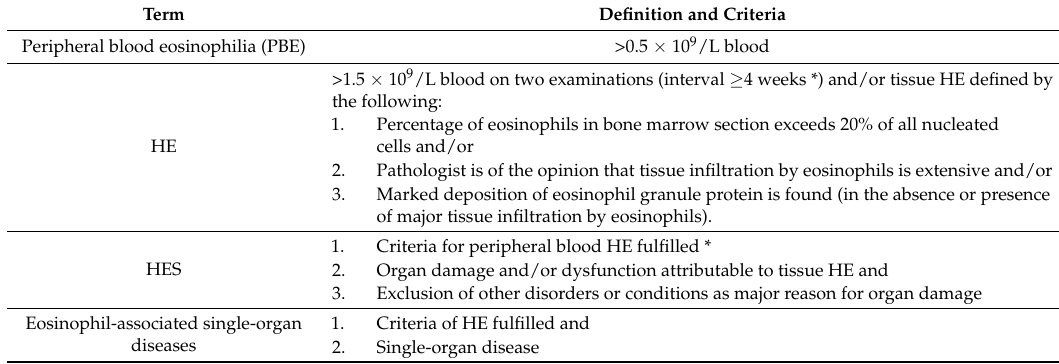
Table 1. Definition of hypereosinophilia (HE) and the hypereosinophilic syndrome (HES) proposed by the International Cooperative Working Group on Eosinophil Disorders